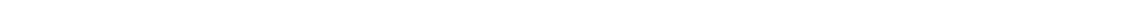
Fig. 1 Mutational landscape of adult LMS. a Frequency and type of mutations. Rows represent individual genes, columns represent individual tumors. Genes are sorted according to frequency of SNVs/indels (left). Asterisks indicate signi fi cantly mutated genes according to MutSigCV. Bars depict the number of SNVs/indels for individual tumors (top) and genes (right). Established cancer genes are shown in bold. Types of mutations and selected clinical features are annotated according to the color codes (bottom). b Schematic representation of SNVs/indels in TP53 , RB1 , and ATRX . Protein domains are indicated (Trans transactivation domain, SH3 Src homology 3-like domain, Tetra tetramerization domain, DUF3452 domain of unknown function, RB_A RB1- associated protein domain A, RB_B RB1-associated protein domain B, RB_C RB1-associated protein domain C, EZH2-ID EZH2 interaction domain, SNF2 N ter SNF2 family N-terminal domain, Hel helicase domain). c Top subnetworks from HotNet2 analysis of genes harboring SNVs/indels. MutSigCV P